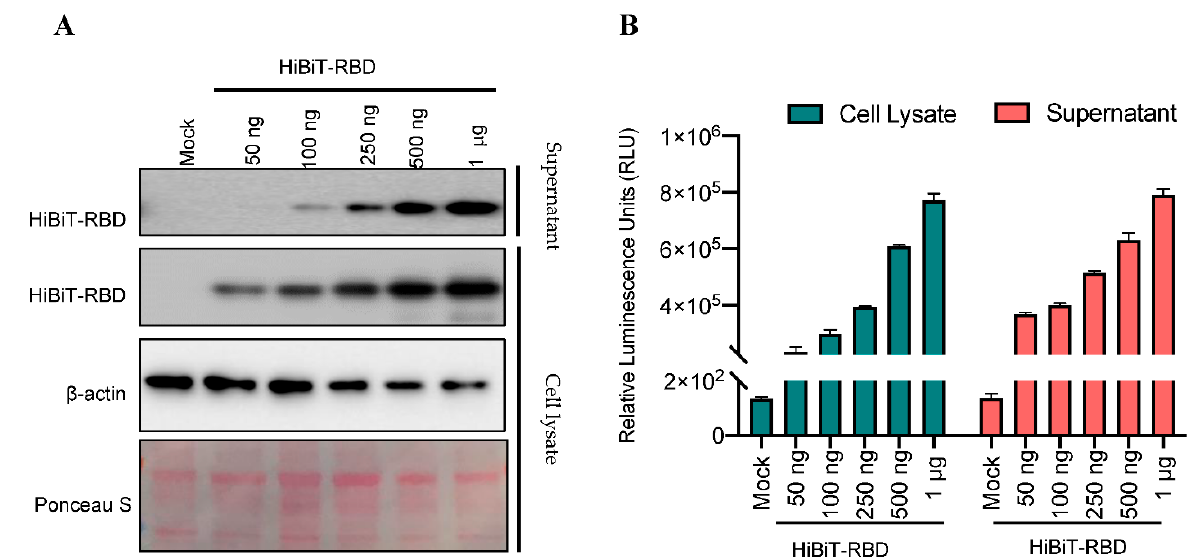
Figure 3. Dose-dependent detection of active HiBiT-RBD in cell lysates and supernatants. ( A ) HEK293T cells were transiently transfected with increasing amounts of HiBiT-RBD (50 ng to 1 μ g) or pcDNA3.1 empty vector control (1 μ g total). Harvested whole cell lysates and supernatants were immunoblotted and probed for RBD. Beta-actin was used as a loading control, and Ponceau staining shows total protein. ( B ) Relative luminescence signal with LgBiT-substrate treatment of both cell lysates and supernatants.